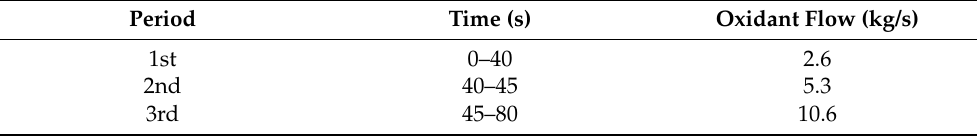
Table 2. Working process of the oxidant